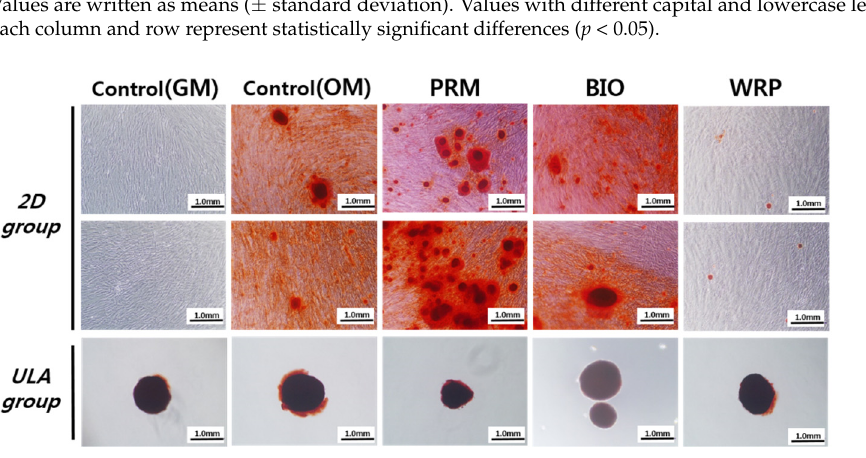
Figure 2. Alizarin red S staining of the DPSCs that were cultured in 2D and ULA culture plates for 21 days.